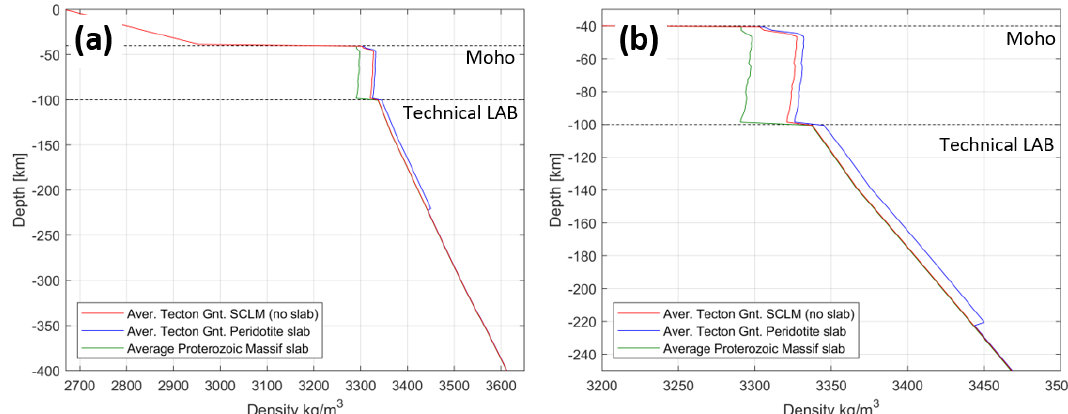
Figure 9. (a) Density profile at 11 ◦ longitude and 45 ◦ latitude for the full vertical model space of 400km depth. Density profiles for three different models ( M 0 , M 1 , M 9 ) with different compositional properties are shown. (b) Zoomed-in profile at the depth range of present slab segments.